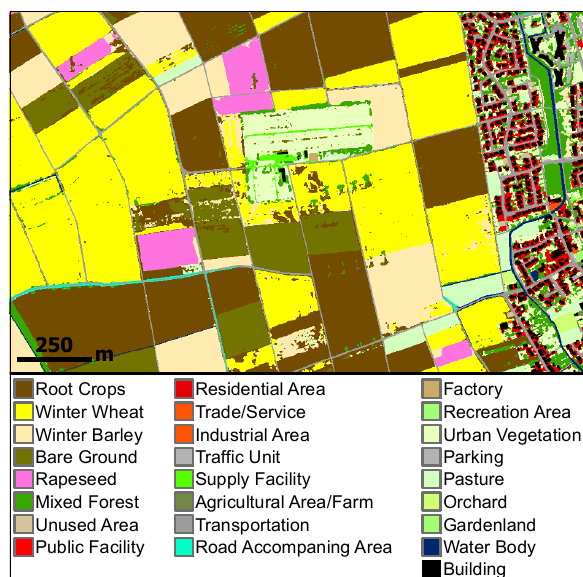
Figure 6. Integration result of selected remote sensing derived class allocations and ALK